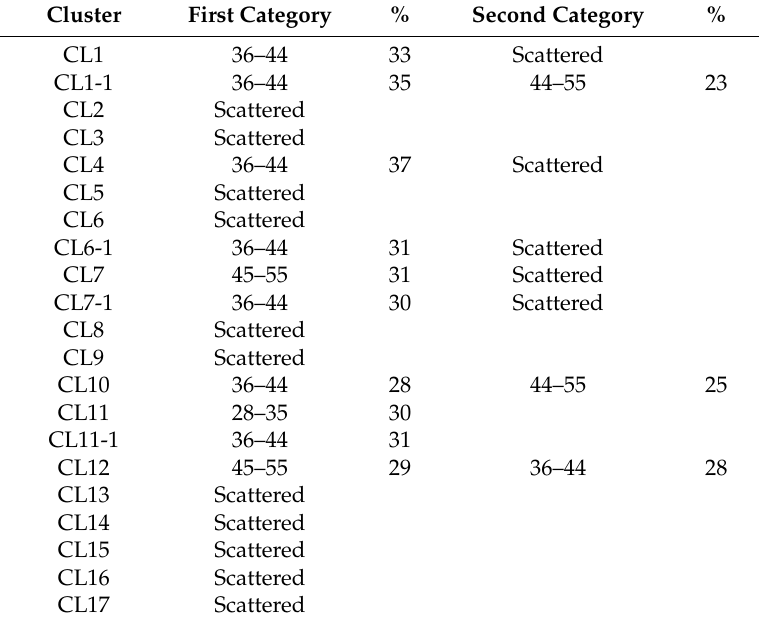
Table A7. Clusters description